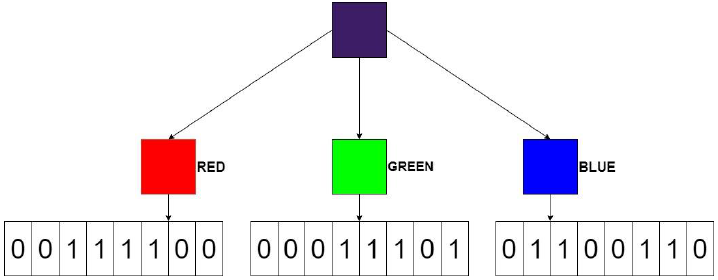
Figure 1. Representation of structure of pixel in png